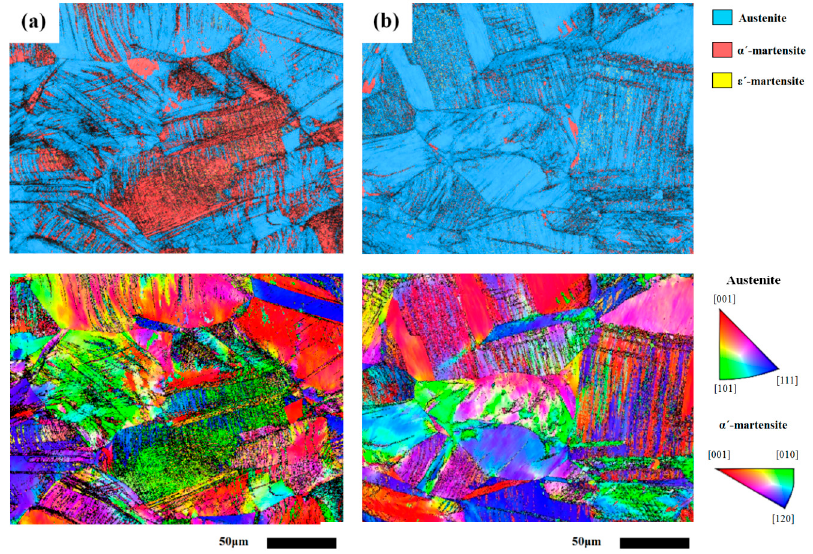
Figure 3. The Electron Backscatter Diffraction (EBSD) image (top) and the corresponding inverse pole figure IPF (Inverse pole figure) (bottom) of ( a ) 304L-CR and ( b ) 304L-CRS specimens.